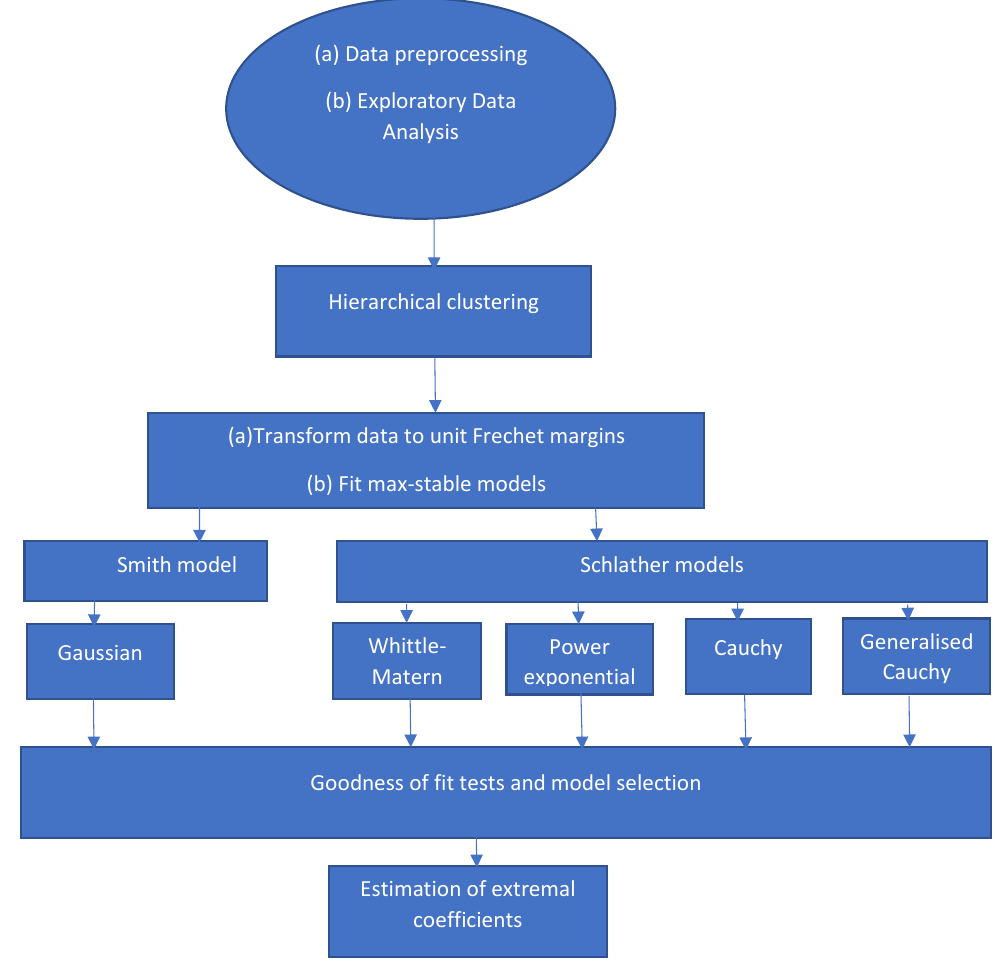
Figure 4. Flowchart showing the modelling process. Source: Authors’